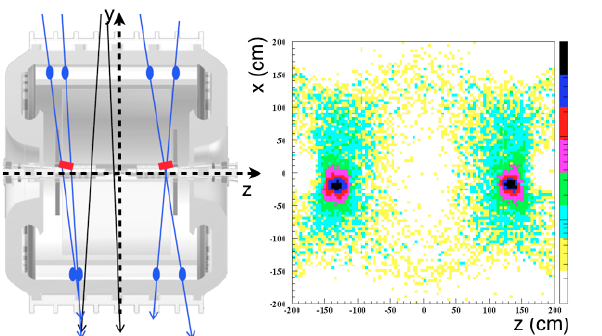
Figure 3. Left : Red boxes represent the two LET stations fired by cosmic-ray muon tracks, displayed as solid blue lines. Tracks are selected by requiring two energy depositions in the barrel EMC with E > 5 GeV and at least one LET crystal fired, z , y axes are reported (dashed arrows). Right : Positions of the let stations in the x − z plane as measured by using selected muon